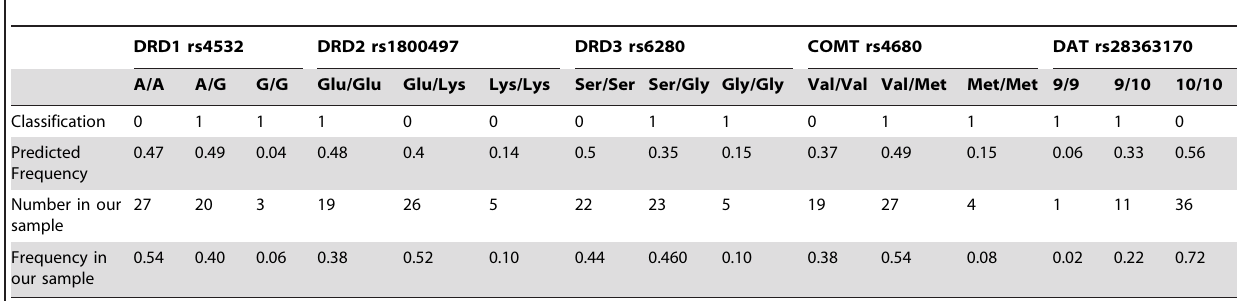
Table 1. Summary of polymorphisms and classification for gene